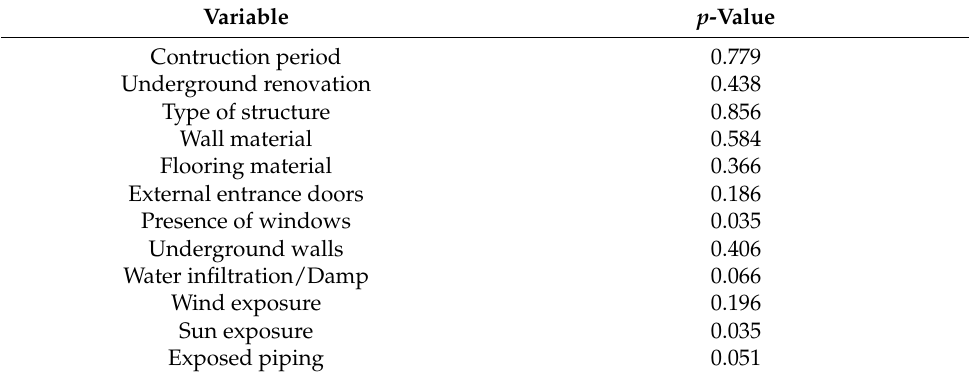
Table 4. Statistical significance in the differences between radon concentrations in relation to the absence/presence of certain variables within the premises